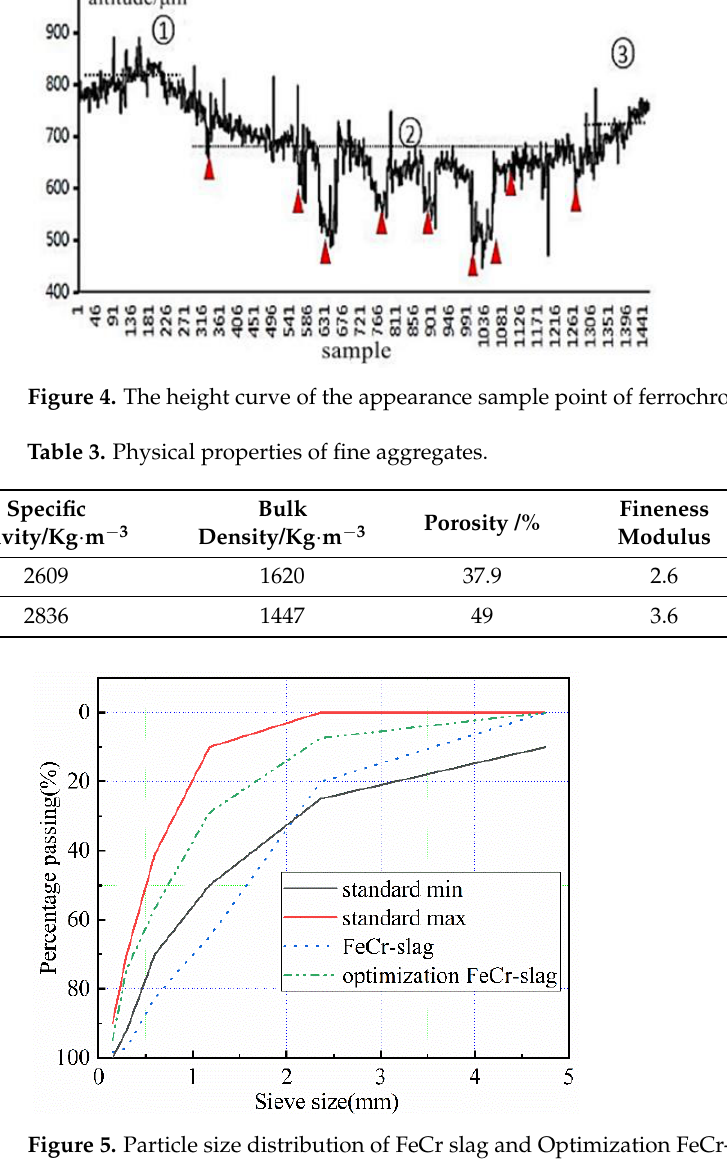
Table 4. Physical performance index of coarse aggregate.